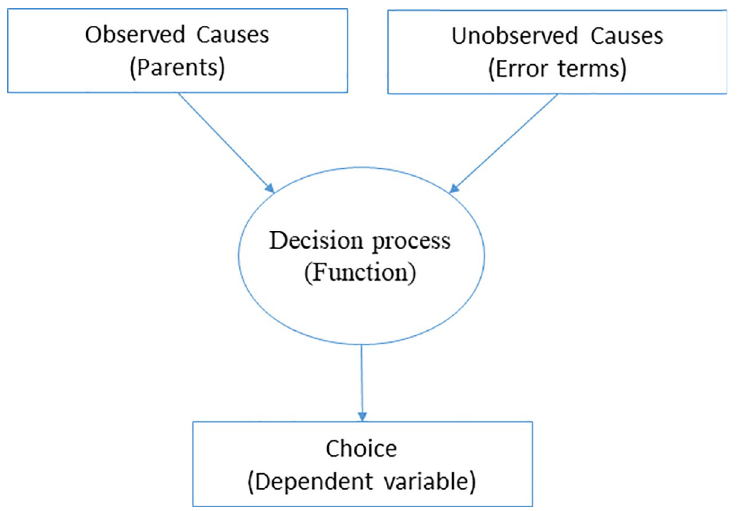
Fig 1. Graphical representation of a structural equation for a single decision